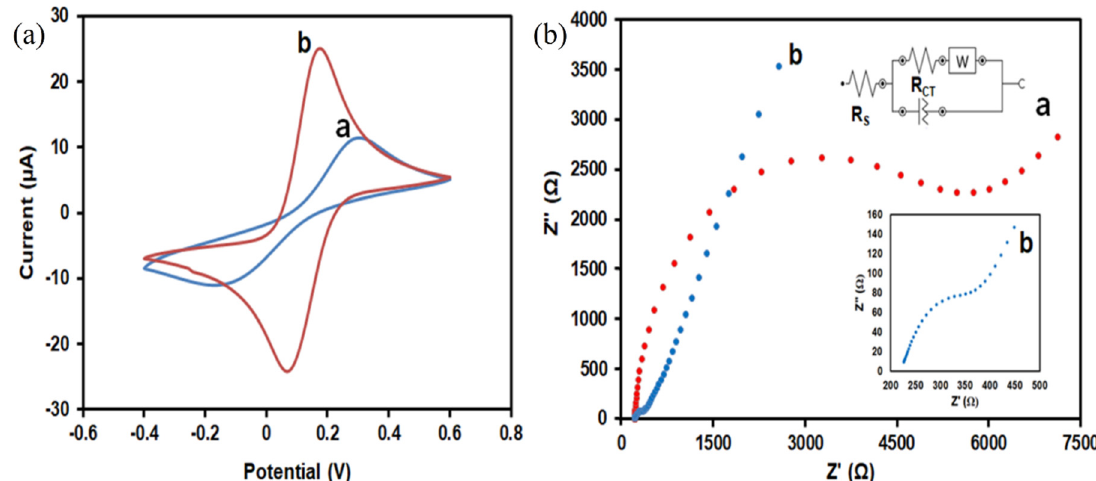
Figure 4. ( a ) Cyclic voltammetry (CV) responses of the a) bare SPCE and b) SiNPs/SPCE. ( b ) Nyquist plots of electrochemical impedance spectroscopy (EIS) for the a) bare SPCE and b) SiNPs/SPCE. The inset shows the Nyquist plot of the SiNPs/SPCE.